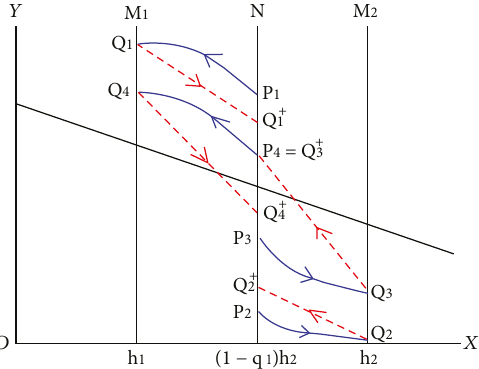
Figure 8: Successor function of system